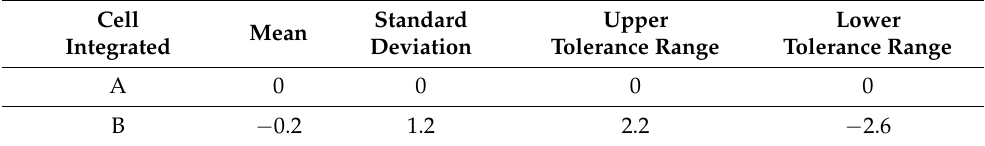
Table 4. Statistical analysis of the error distribution for Concept Y.